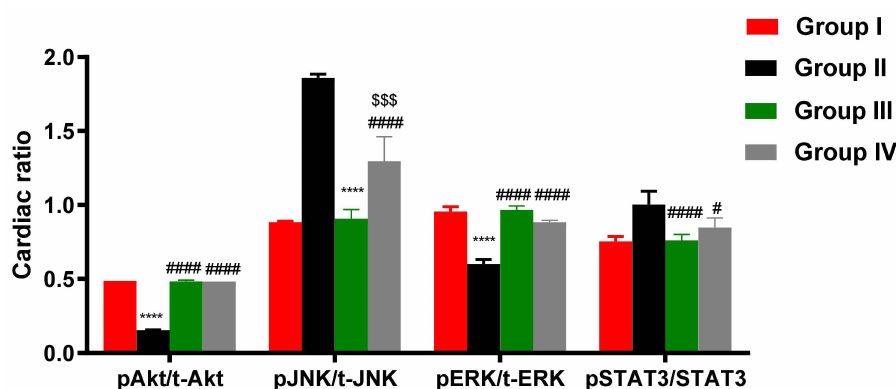
Figure 9. Effect of ADMSCs-derived exosomes on pAKT/AKT, pERK/ERK, pJNK/JNK, and PSTAT3/STAT3 in cardiac tissue of DOX/Trz-treated rats: (A) pAKT/AKT, pERK/ERK, and pJNK/JNK; and (B) PSTAT3/STAT3. Results are expressed as mean ± SEM. ****, significant compared to Group I at p < 0.0001; #, significant compared to Group II at p < 0.05; ####, significant compared to Group II at p < 0.0001; $, significant compared to Group III at p < 0.05; $$$, significant compared to Group III at p < 0.001; n =